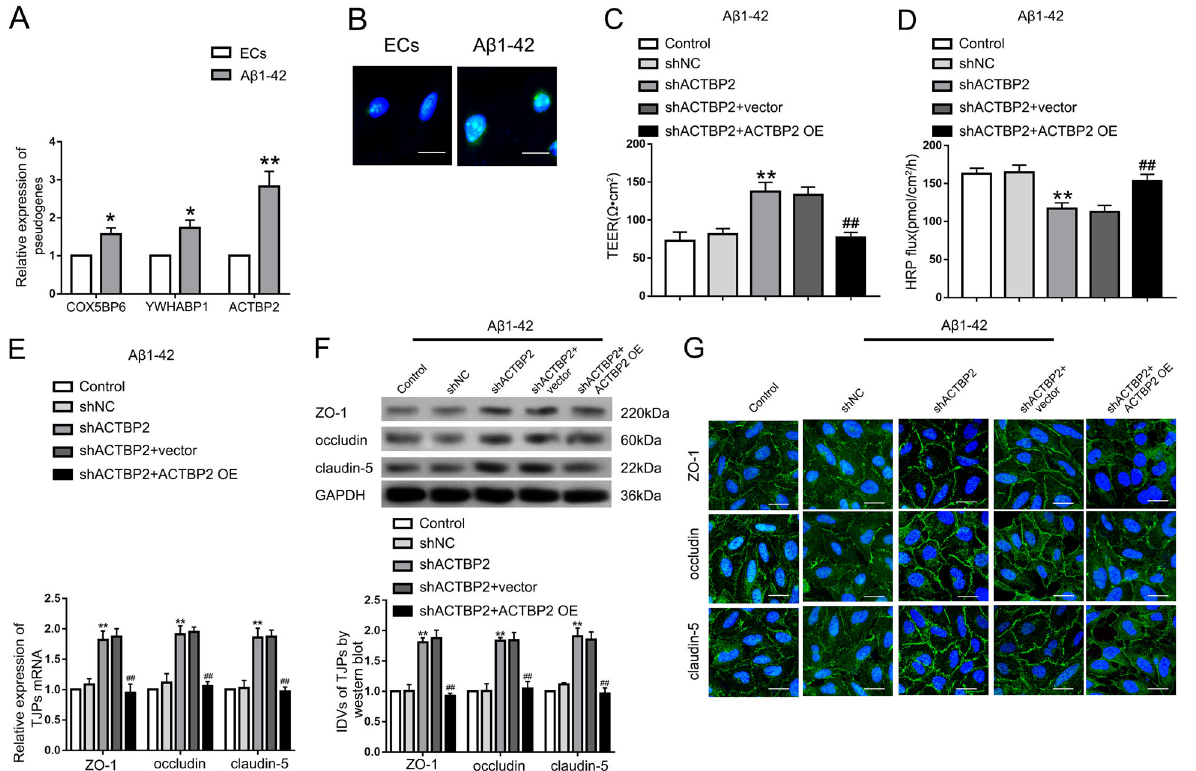
Fig. 1 The expression of ACTBP2 in ECs pre-incubated with A β 1 – 42 and the effect on the BBB permeability in A β 1 – 42 microenvironment. A Relative expression of COX5BP6, YWHABP1, and ACTBP2 in A β 1 – 42 -incubated ECs by qRT-PCR. Data are presented as mean ± SD ( n = 3), * P < 0.05 versus ECs group, ** P < 0.01 versus ECs group. B Fluorescence in situ hybridization (FISH) analysis of the location of ACTBP2 (green) mainly in the nucleus of A β 1 – 42 -incubated ECs. Scale bar represents 30 μ m. C , D Effects of ACTBP2 on TEER values ( C ) and HRP fl ux ( D ) in A β 1 – 42 microenvironment. E Effects of ACTBP2 on ZO-1, occludin, and claudin-5 expression levels in ECs pre-incubated with A β 1 – 42 determined by qRT-PCR. F Effects of ACTBP2 on ZO-1, occludin, and claudin-5 expression levels in ECs pre-incubated with A β 1 – 42 determined by western blot. Data are presented as mean ± SD ( n = 3, each). ** P < 0.01 versus shNC group. ## P < 0.01 versus shACTBP2 + vector group. G Effects of ACTBP2 on ZO-1, occludin, and claudin-5 expression levels and distribution in A β 1 – 42 microenvironment determined by immuno fl uorescence staining. ZO-1, occludin, and claudin-5 (green) were labeled with secondary antibodies against anti-ZO-1, anti-occludin, and anti-claudin-5 antibodies, respectively, and nuclei (blue) were labeled with DAPI. Scale bar represents 30 μ